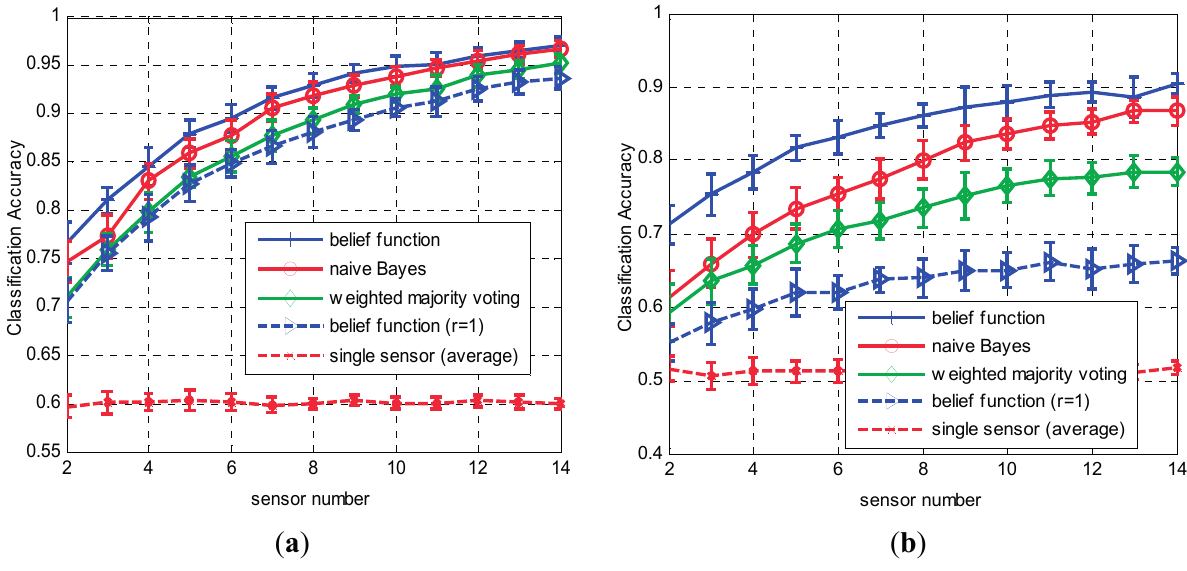
Figure 5. Average classification accuracy (plus and minus one standard deviation) as a function of sensor number, obtained by 20 repetitions. The value of coefficient α is fixed as 1.5 and the used classifiers in subplots ( a , b ) are k -NN and ELM neural network, respectively.